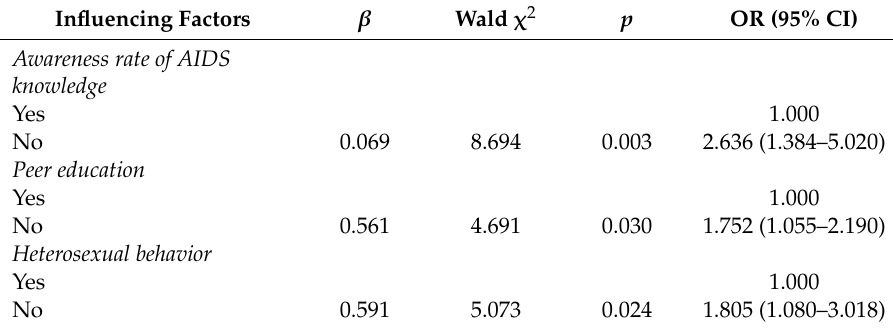
Table 5. A multivariate logistic regression analysis of the influencing factors of